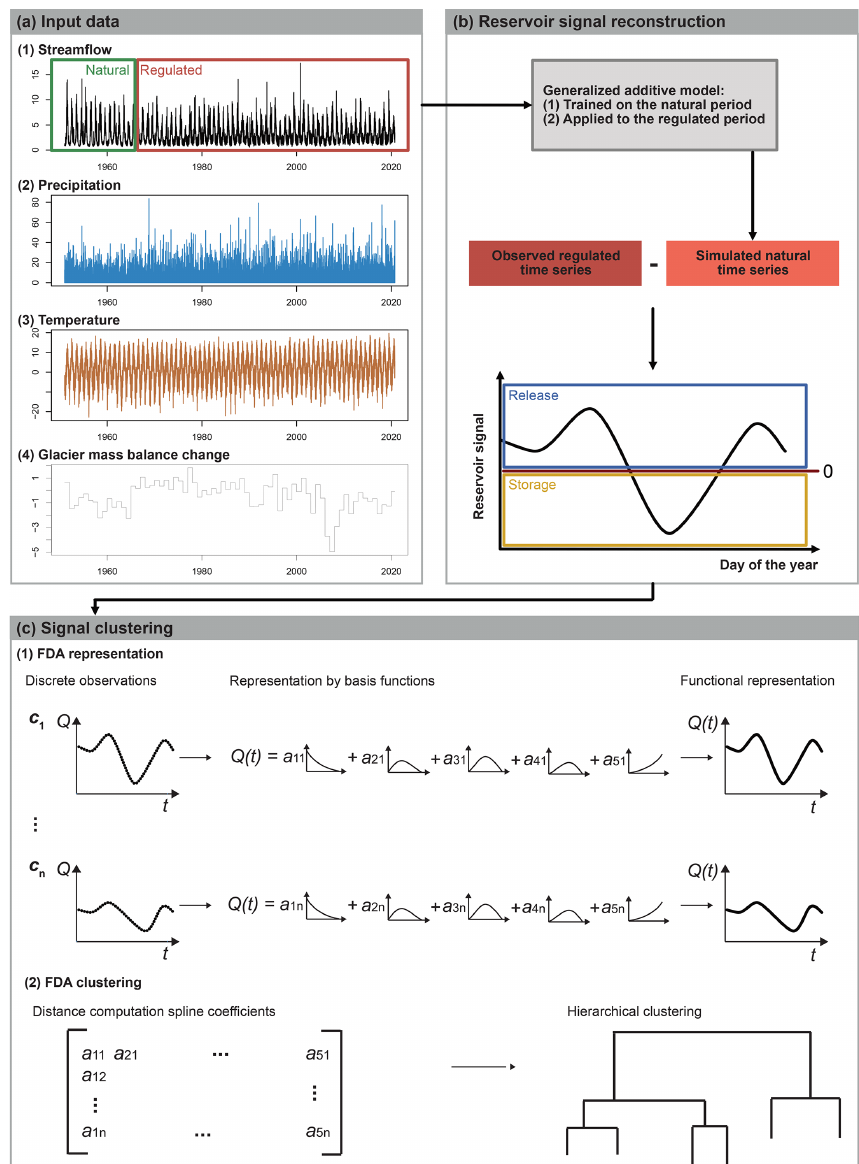
Figure 3. Workflow illustration. (a) Input data used to fit and run the generalized additive model (GAM), including streamflow, precipitation, temperature, and glacier mass balance changes for a period before and after reservoir construction representing natural and regulated con- ditions, respectively. (b) GAM fitting using the natural data before reservoir construction. GAM is used to predict the natural signal for the regulated period, and the regulation signal is reconstructed by subtracting the predicted “natural time series” from the observed regulated time series (i.e. determining the seasons with reservoir storage and release). (c) Reservoir signal clustering using functional data analysis (FDA), using hierarchical clustering on functional representations (i.e. spline basis functions) of the reconstructed signals of all catchments in the